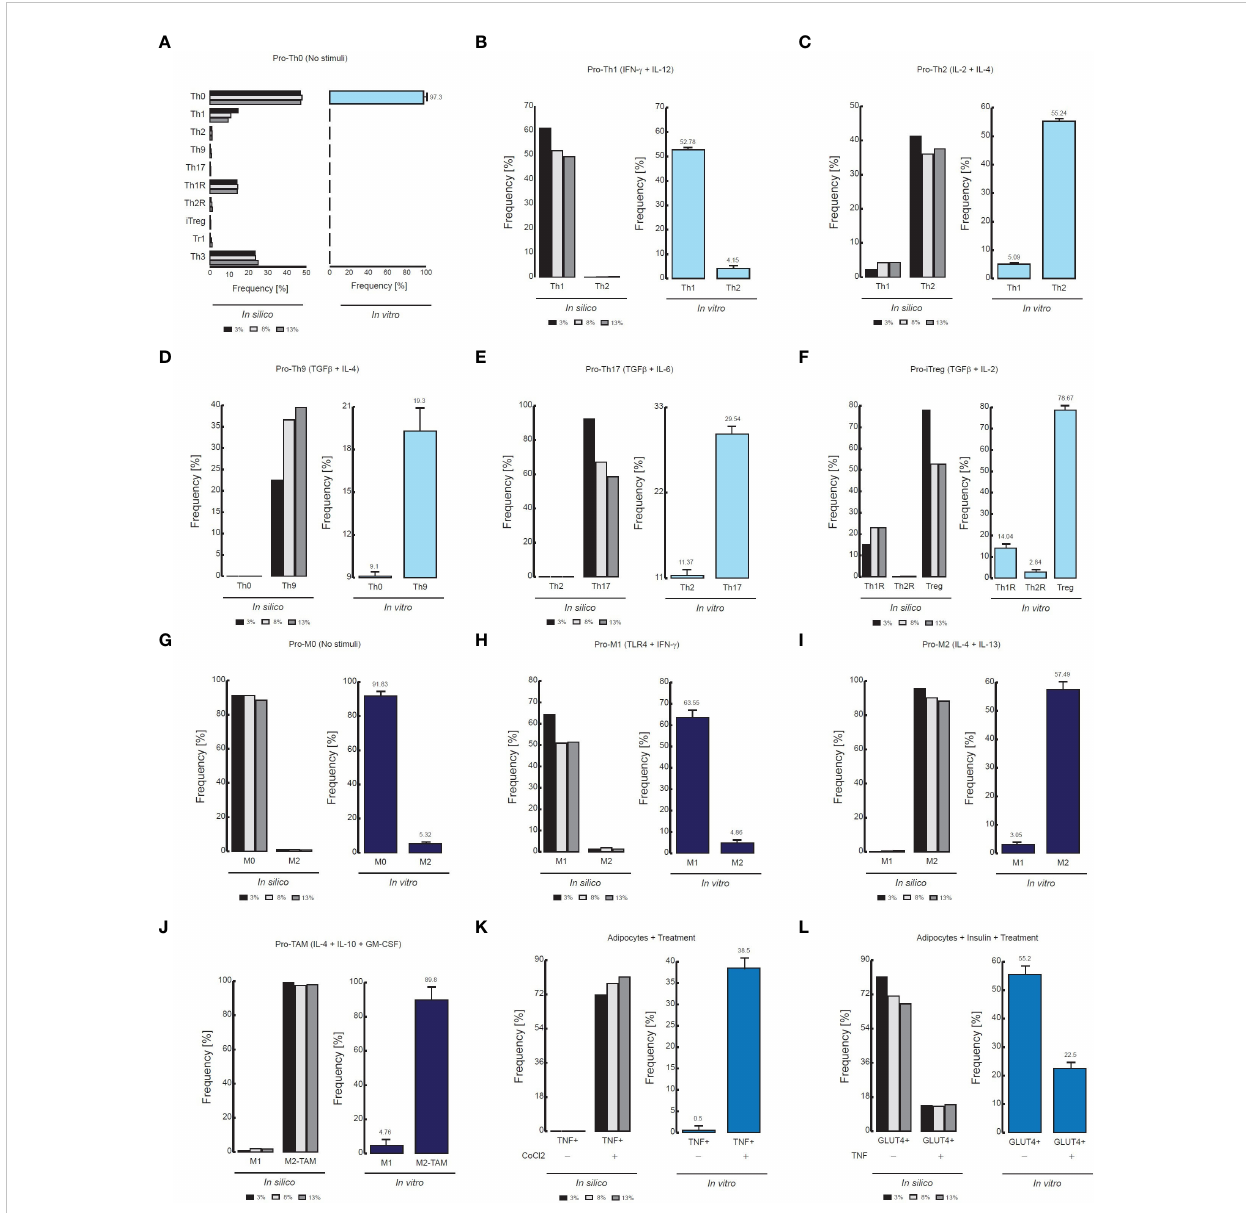
FIGURE 3 Comparison of fl ow cytometry data vs in silico proportions of cell phenotypes. (A) Phenotype distribution of CD4+ T cells without stimuli, (B) in presence of IFN- g and IL-12, (C) in presence of IL-2 and IL-4, (D) TGF- b and IL-4, (E) TGF- b and IL-6, (F) TGF − b and IL-2. For panels D, the fl ow cytometry data was adapted from (24). The data of the remaining panels was adapted from (31). (G) Phenotype distribution of Macrophages without stimuli, (H) in presence of IFN- g and TLR4 ligands, I in presence of IL-4 and IL-13, (J) In presence of GM-CSF, IL-4 and IL-10. The data of (G – I) was adapted from (32), and the data of (J) was adapted from (33). (K) Phenotypic distribution of adipocytes in presence of an in fl ammation inducer, (L) in presence of TNF. For both panels the data was adapted from